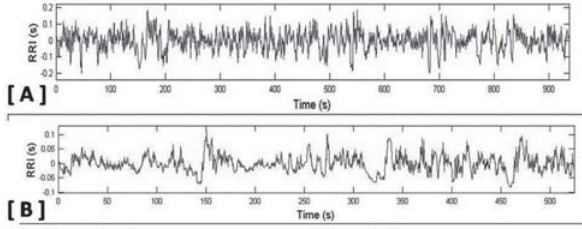
Fig. 1 – Tacograma de um adulto jovem normal (A) e de um recém-nascido normal (B). A variabilidade da frequência cardíaca no painel B está bem menor do que no painel